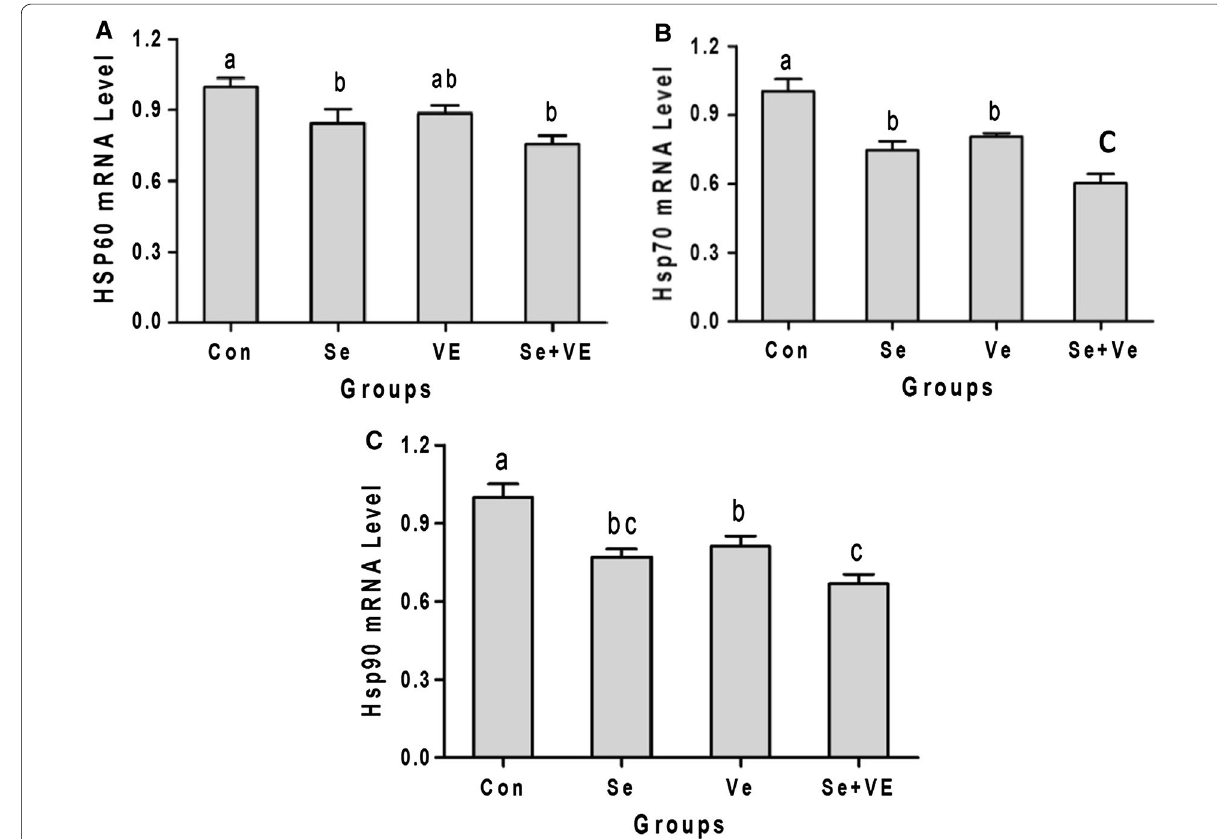
Fig. 6 Effects of Se, VE and Se VE on relative mRNA level of A HSP60 B HSP70 and C HSP90 in breast muscles of heat stressed broiler chickens. + Mean values with their standard errors. The values with unlike superscript letters (a, b, c) in the graph were different (P <